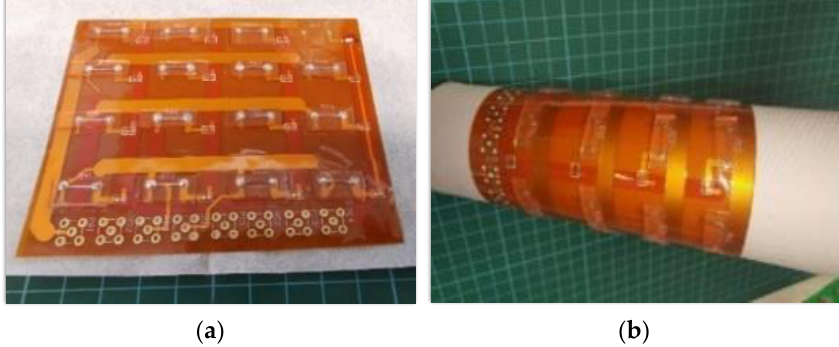
Figure 12. EGaIn based 4 × 4 flexible RSA ( a ) on flat surface and ( b ) on bending surface.